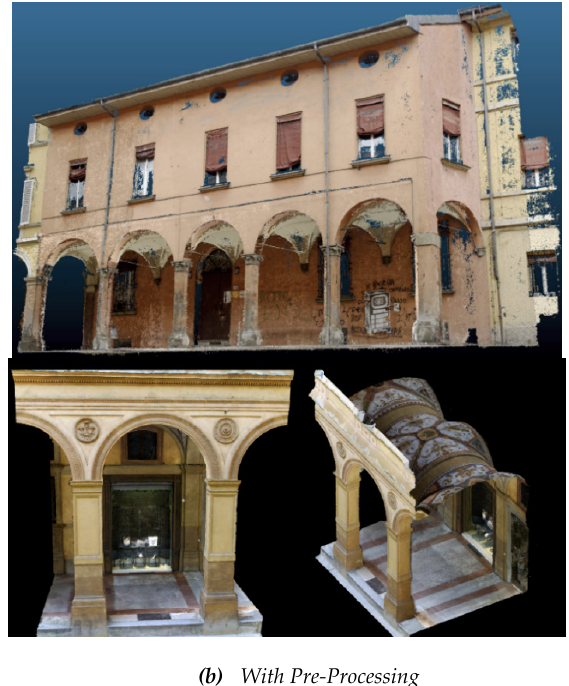
Figure 3. 3D reconstruction of complex architectures without ( a ) and with ( b ) a suitable pre-processing methodology applied to improve the radiometric image quality and provide more complete and noise-free 3D point clouds.